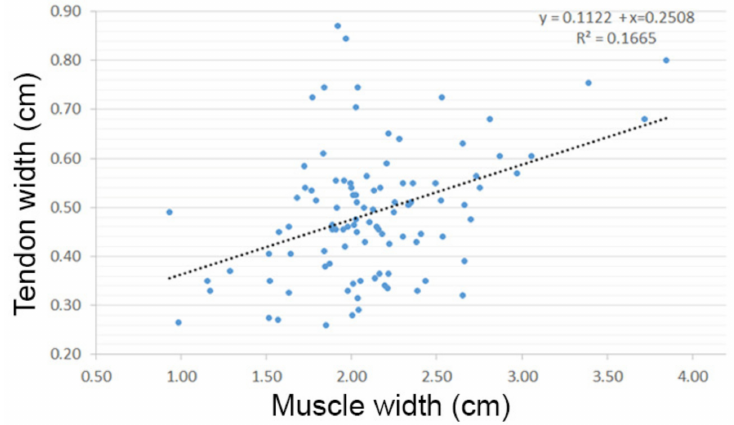
Figure 5. Regression analysis on tendon width versus muscle width. Analysis showed a R-value of 0.408, R 2 of 0.16, and a p- value of 0.0002. It is expected then that a higher muscle width will correlate with a higher tendon